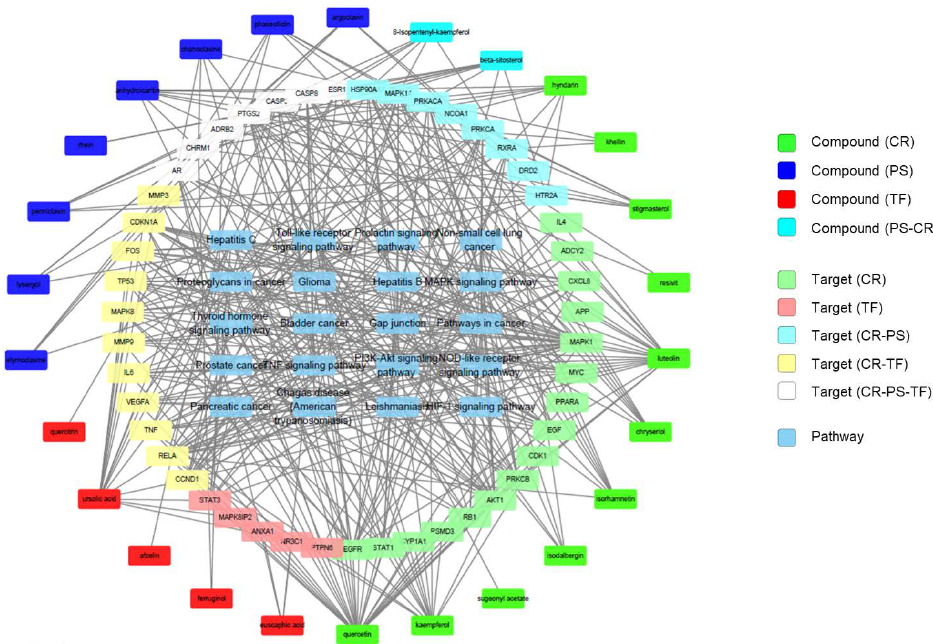
Figure 4. Visualization of the compound-target-pathway network of SCH. In total, 47 nodes of key targets (middle circle) and 26 nodes of compounds (outer circle) related to key targets are presented. A total of 20 significant pathways related to 47 key targets are positioned inside the circle as a